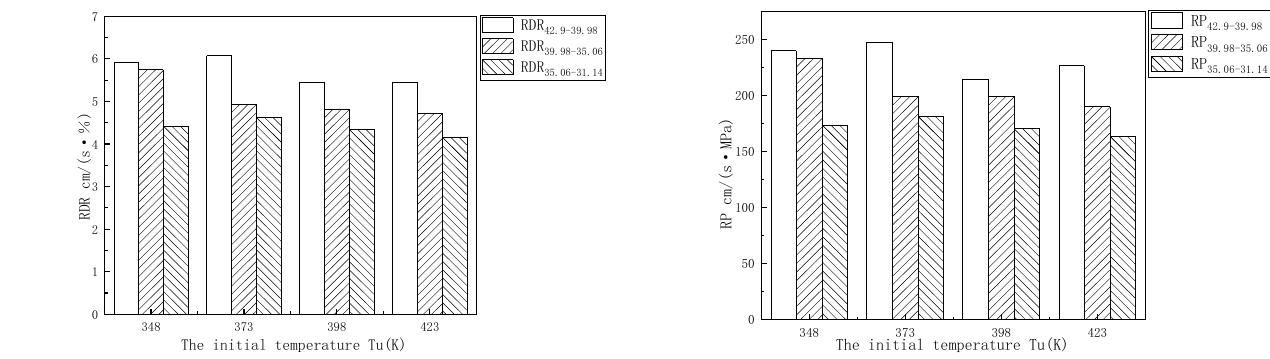
Figure 15. The rate of change R in u L corresponding to Tu. The auxiliary dashed curves in Figure 13 stand for the equivalent effect on the u L of Pu and DR. The specific equivalent relationship is that the Pu change of ΔP = 0.05 MPa and the DR change of 2% have equivalent effects on the same variation value of u L . The intersection of the isolines of u L and the auxiliary dashed curves in the figure indicates that Pu and DR have an equal influence weight on u L at this point. All the equal weight intersection points in the figure are extracted and fitted onto curves (refer to Figure 16), and two regions are formed by equal weight curves. Region I is the area where the DR has a greater influence on u L , while in region II, Pu has a greater influence on u L . This shows that, under the influence of the coupling effect of Pu and DR on u L , Pu of the low-pressure and high-dilution rate area has a greater weight on u L . As the initial temperature increases, the equal weight curves of Pu and DR exhibit different movement patterns.